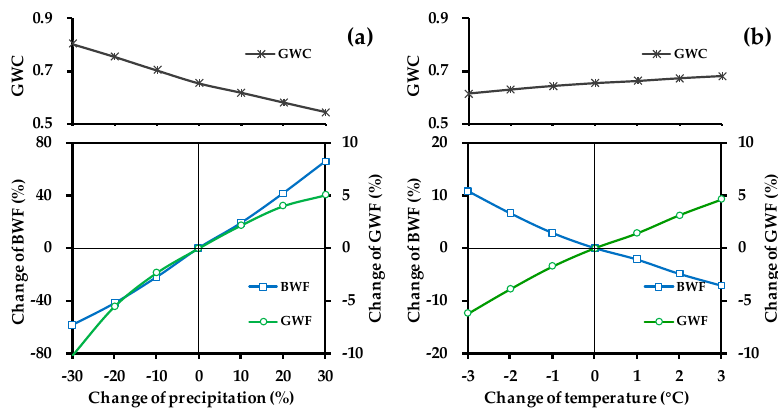
Figure 11. Sensitivity on BWF, GWF, and GWC impacted by precipitation change ( a ) and temperature change ( b ) in the ELB.